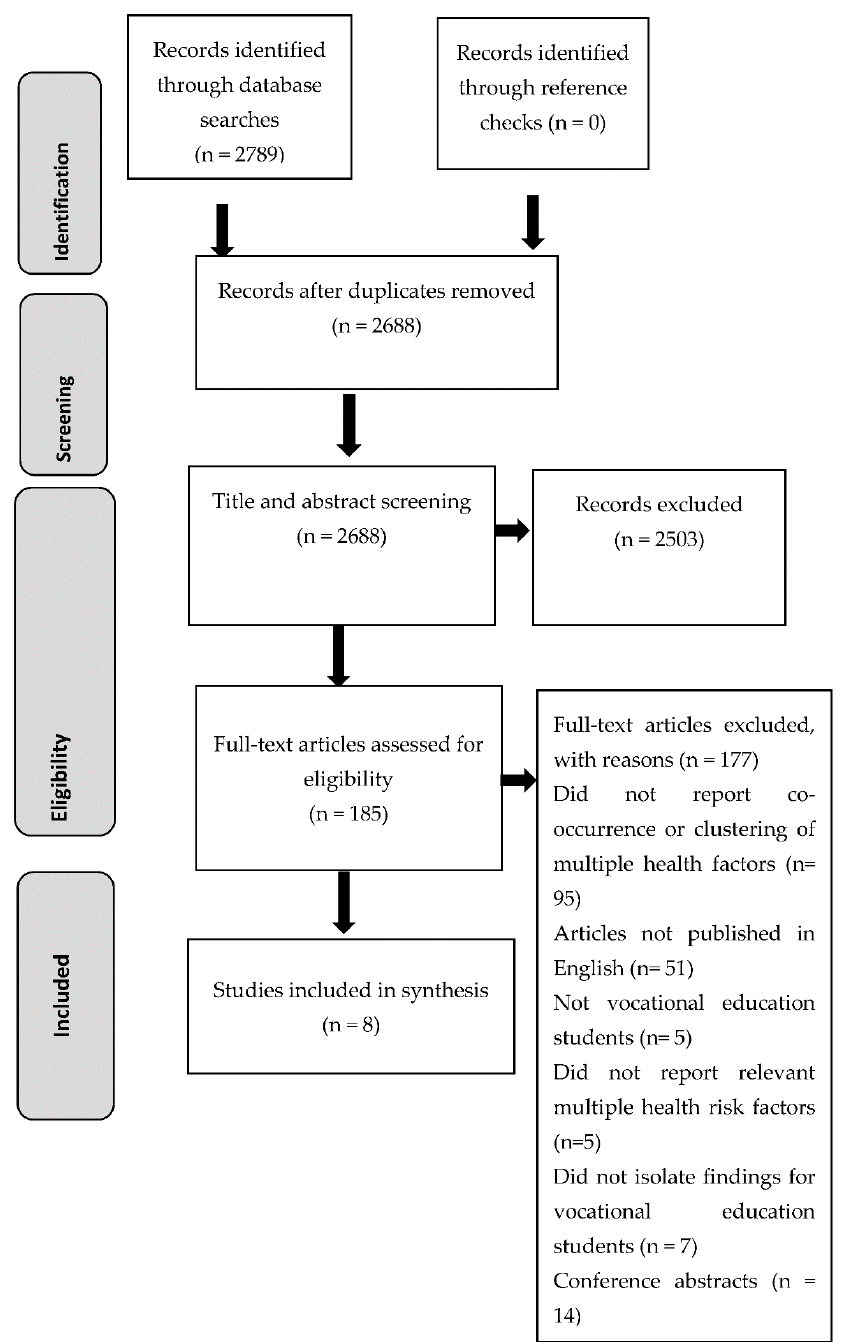
Figure 1. PRISMA diagram of screening and selection process.